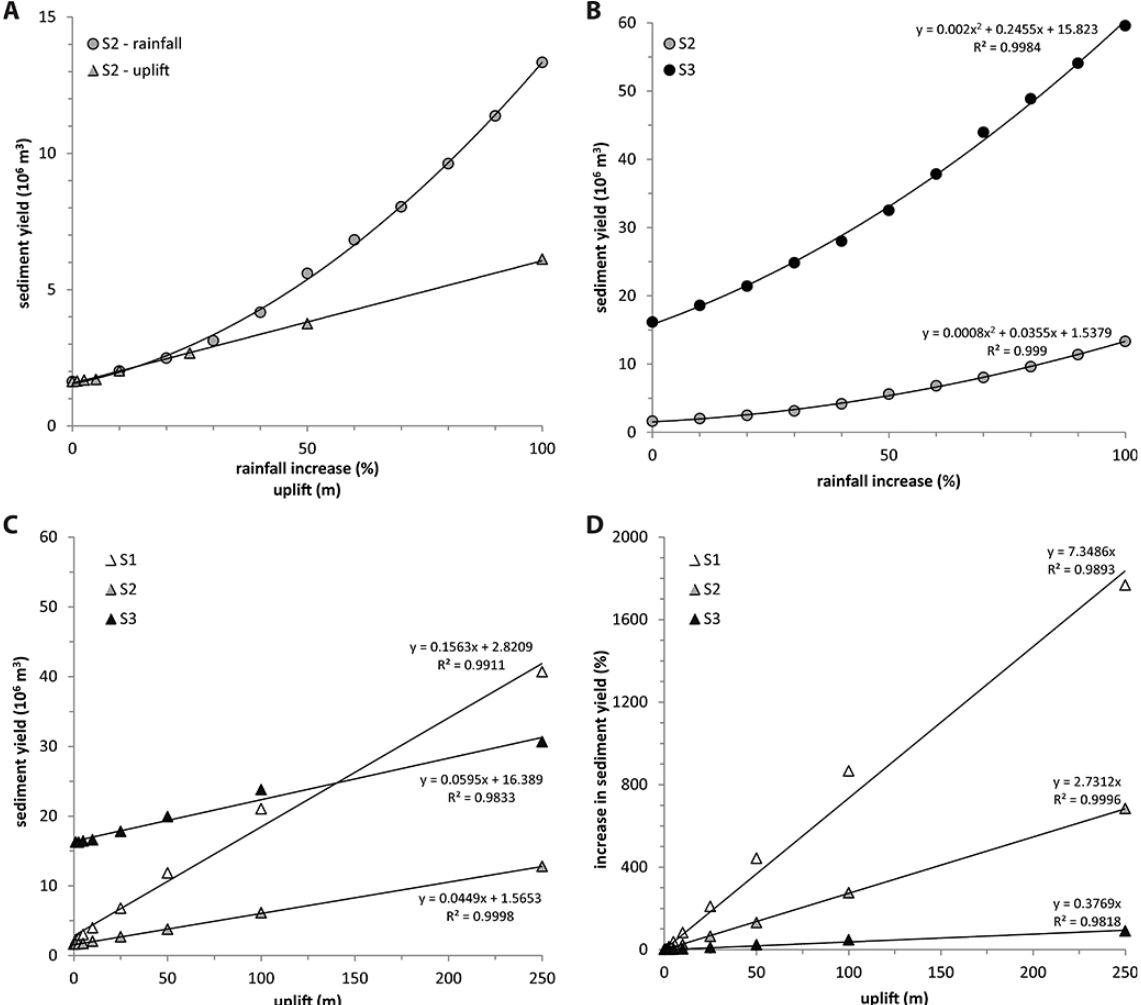
Figure 4. Impact of rainfall increase or tectonic uplift on simulated sediment yields after 100yr, at point S1, S2 and S3 (see Fig. 1 for locations). (A) Impact of rainfall increase and tectonic uplift on sediment yield after 100yr, at S2. (B) Total sediment yield for rainfall scenarios, at S2 and S3. (C) Total sediment yields for instantaneous uplift scenarios, at S1, S2 and S3. (D) Percentage change in sediment yield, relative to the base scenario, for instantaneous uplift scenarios, at S1, S2,